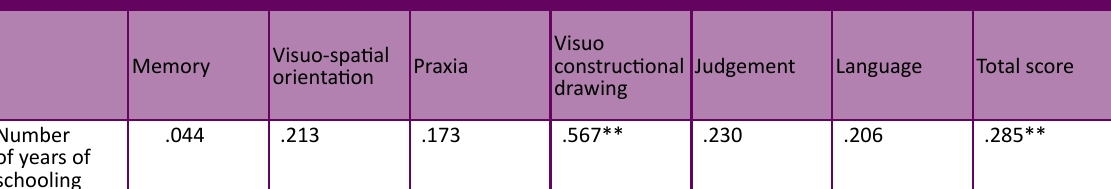
Table 4 – Correlation of the sub- scores of RUDAS with the number of years of